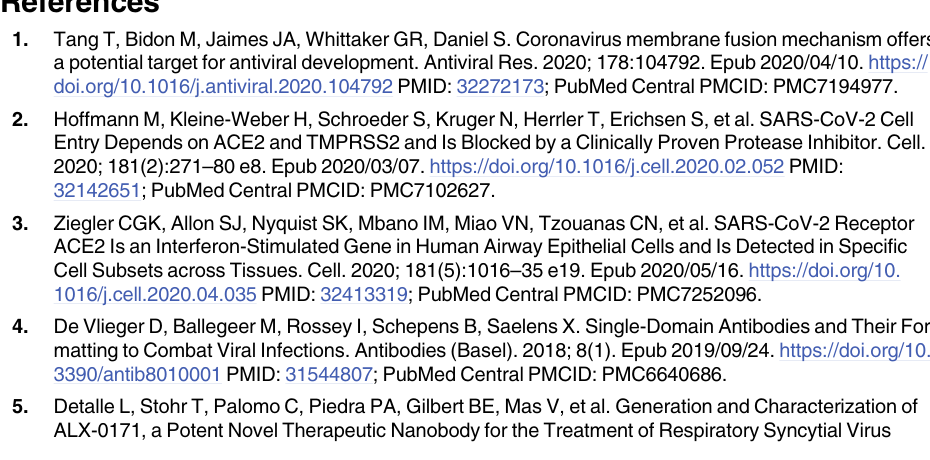
Day 0 is 100%. (C) Amounts of viral RNA in the lung homogenates at Day 4 were determined by qRT-PCR. ( D ) qRT-PCR results showing inflammatory cytokine expression. Expression levels of IL-6, IL-10, TNF- α and IL-1 β were assessed in lung homogenates collected at Day 4. (TIF) S10 Fig. Schematic diagram indicating K-874A binding domain (A) and ACE2-blocking VHHs binding domain (B). Trimer of S proteins, ACE2 and VHHs were depicted and ACE2 binding domain of RBD was depicted in red. K-874A binds NTD and RBD, while previous reported VHHs binds the surface of ACE2 binding interface.